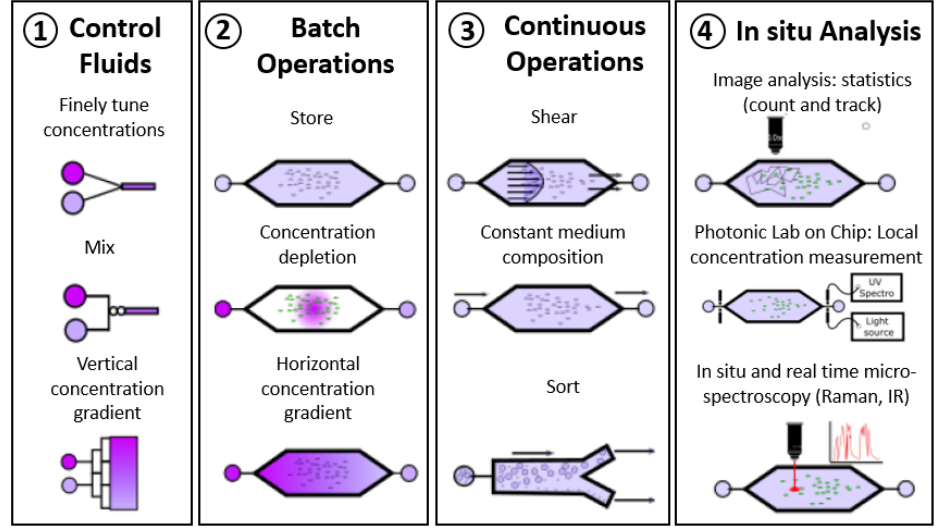
Figure 5. Advantages offered by microfluidic set-up for studying cells. The microfluidic set-up takes advantage of a fine control of hydrodynamics, ( 1 ) on the way that the microfluidic device is operated (batch ( 2 ) or continuous mode ( 3 )) and on the opportunity to perform local and in-situ analyses ( 4 ).